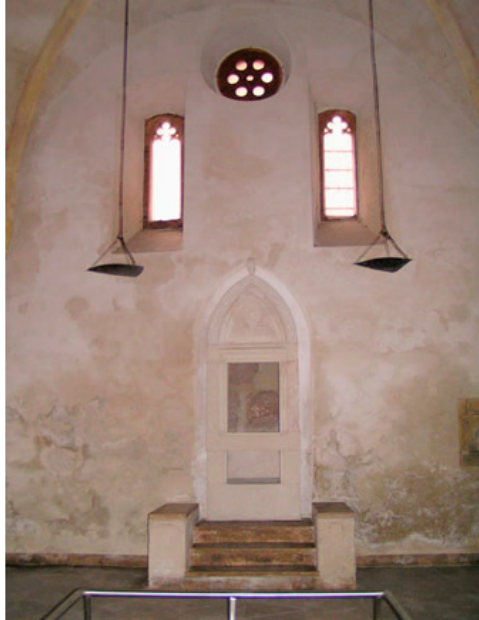
Figure 8. Private Synagogue, Sopron (Simon Paulus, ca. 1970, used with permission). Arts 2020 , 9 , x FOR PEER REVIEW